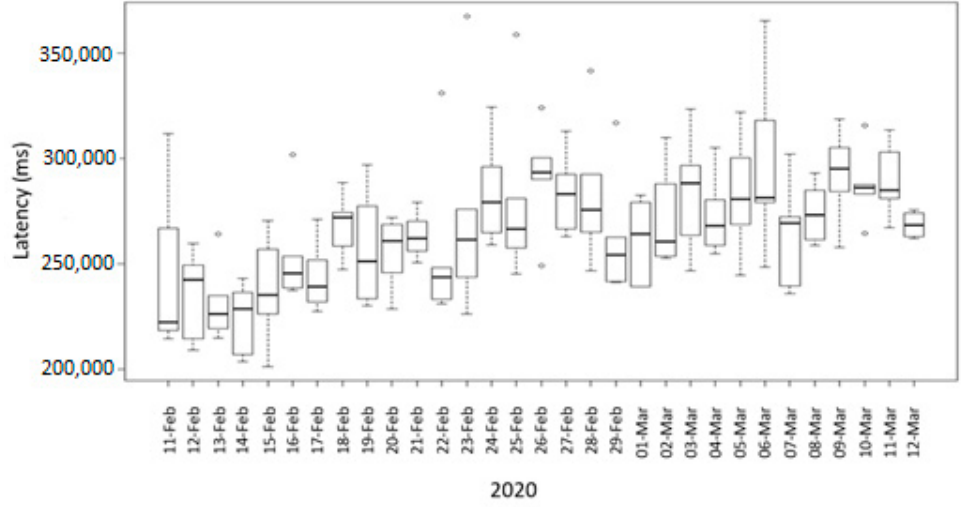
Figure 10. Daily latency of an ASS for one month.